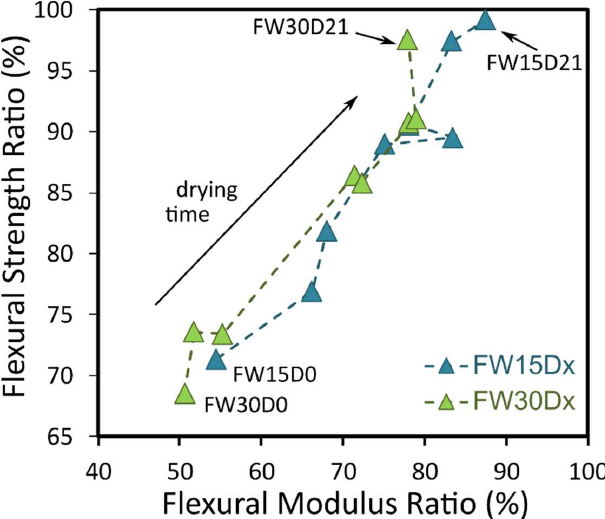
Figure 4. Flexural strength vs. modulus ratio at varying dry times of flax laminates.